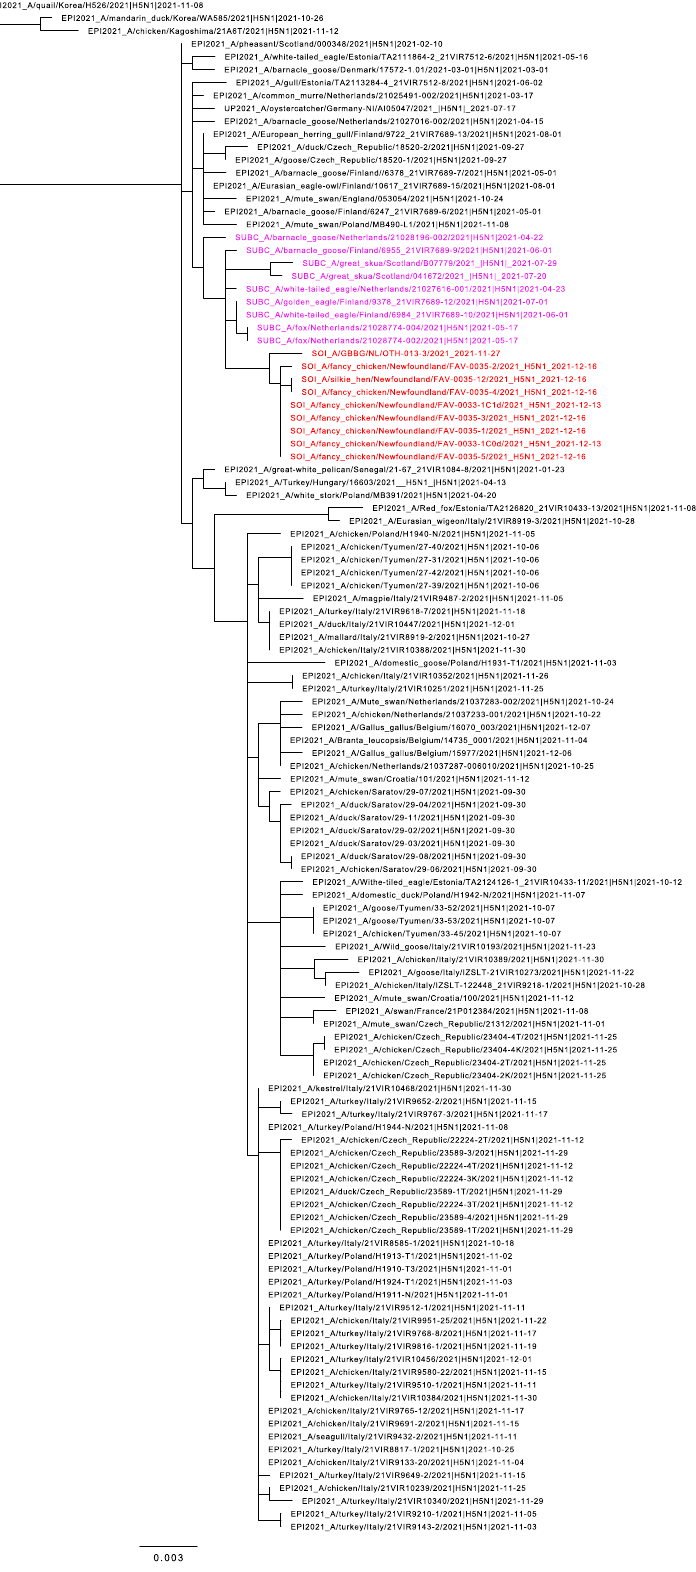
Figure 2. Maximum likelihood phylogenetic tree of the H5 gene segments. Relationships among the European 2021 H5 2.3.4.4b HPAI strains (magenta) and the Newfoundland wild bird and outbreak strains (red) are shown. The tree is rooted by the outgroup and nodes placed in descending order; order: HA, NA, PA, PB1, PB2, NP, MP,